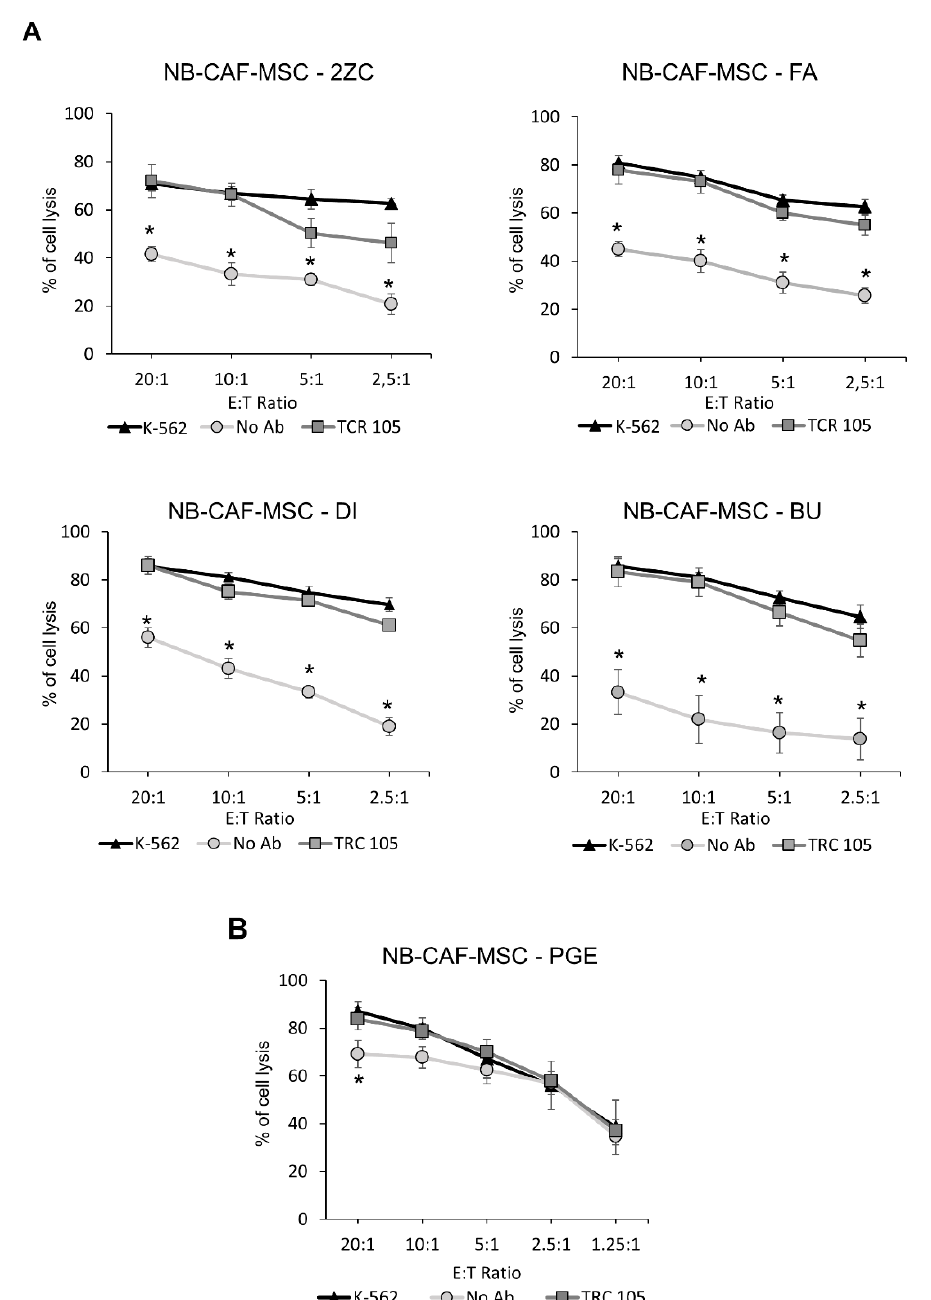
Figure 3. Susceptibility of primary NB-TA-MSC cultures to aNK cell-mediated lysis. ( A ) Allogeneic aNK cells were used as effector cells against CMFDA-labelled young/proliferating and ( B ) Senescent NB-TA-MSC-PGE primary cultures. Target cells were labelled with CMFDA, and allogeneic aNK cells were used as effectors at different E:T ratios as indicated. CMFDA-labelled K-562 cells were used as a positive control of lysis (K-562). An anti-CD105 IgG mAb, that induced ADCC (TRC 105) or irrelevant IgG mAb as a control (No Ab) was used. Data were expressed as mean ± SD ( n = 4) of the percentage of cell lysis (CMFDA+ and PI+ cells). * p < 0.05 No Ab vs. K-562.